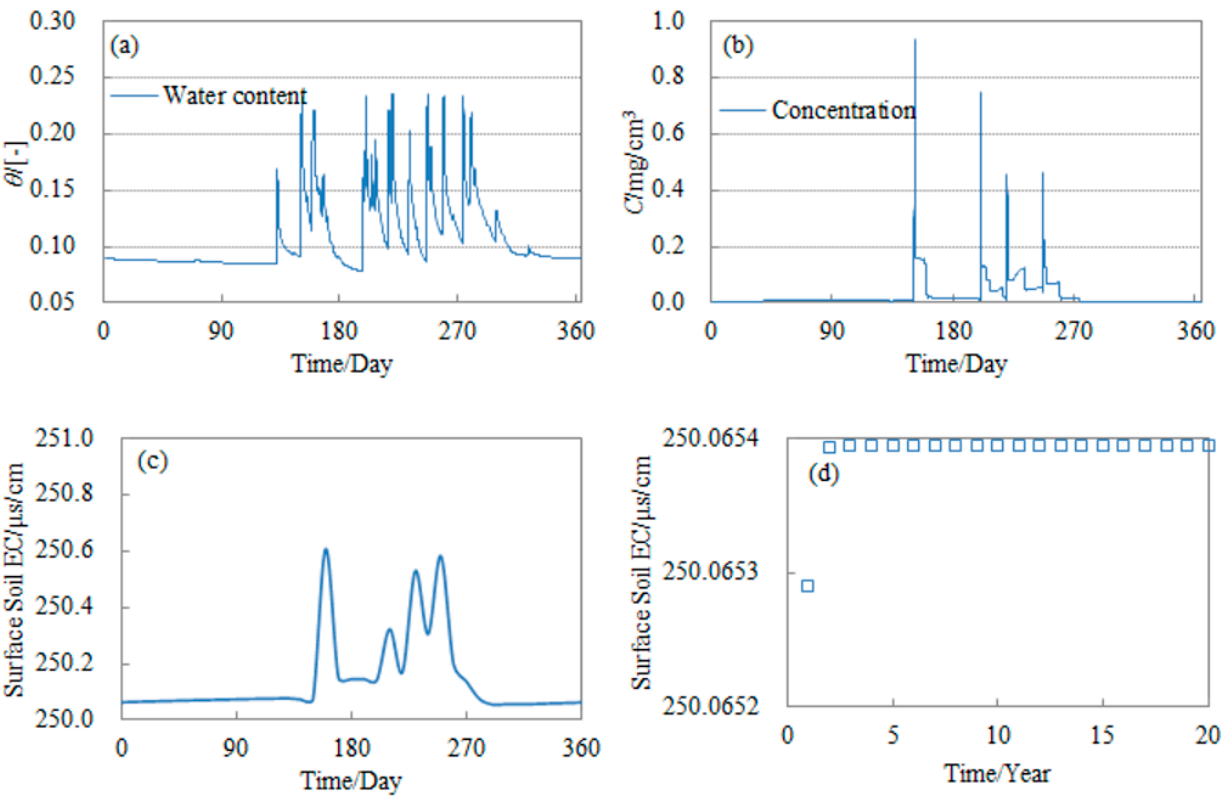
Figure 9. Annual and interannual changes in water and salt in sprinkler irrigation. ( a ) Water content at observation point; ( b ) concentration of soil solution at observation point; ( c ) annual variation in topsoil salinity; ( d ) interannual variation in topsoil salinity.